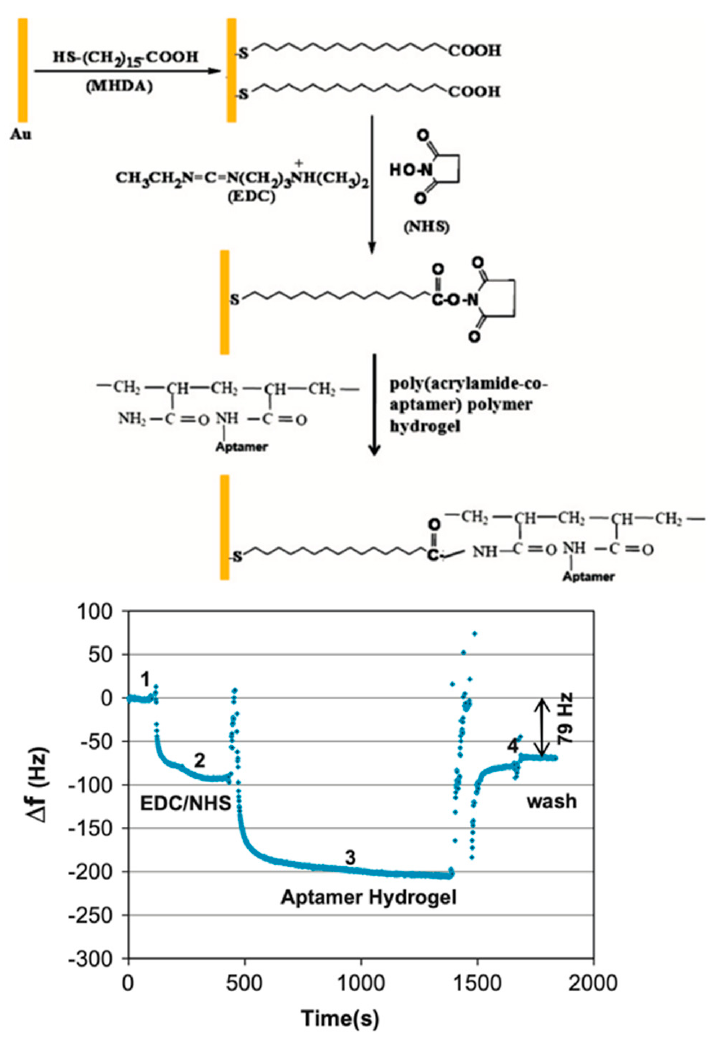
Figure 4. Preparation of aptamer hydrogel-coated QCM aptasensor and QCM sensorgram: (1) SAM created on the sensor in equilibrium with distilled water; (2) NHS/EDC activation; (3) poly(acryla- mide) co-aptamer polymer hydrogel immobilization; (4) washing to obtain the baseline. Reprinted with permission from Ref. [114] 2013,